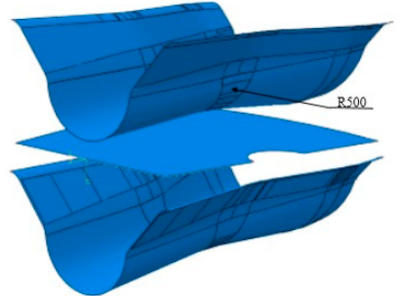
Figure 11. FEM model of the die of sheet metal preforming process.